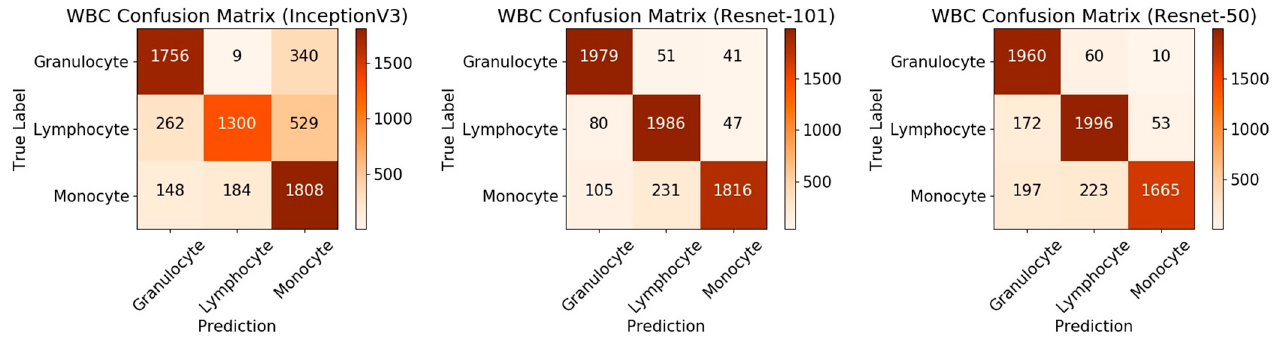
Figure 8. Comparison results of the confusion matrix for the three models.